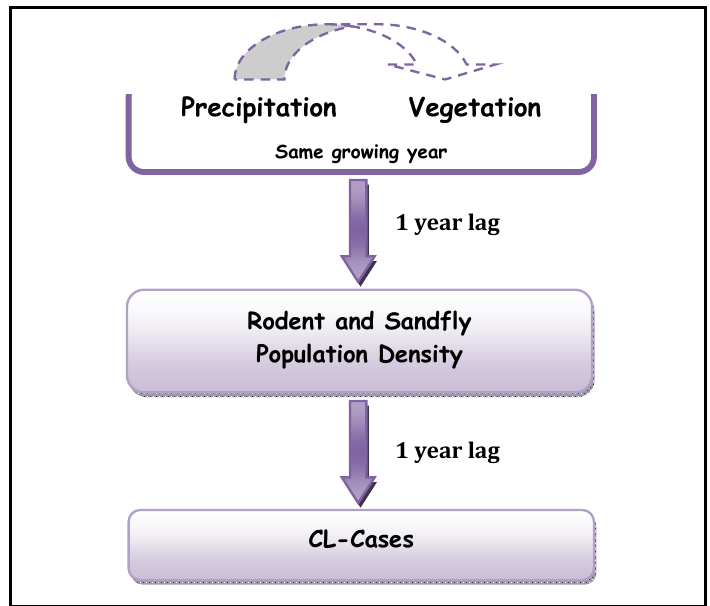
Figure 5. Proposed Trophic Cascade in Leishmaniasis